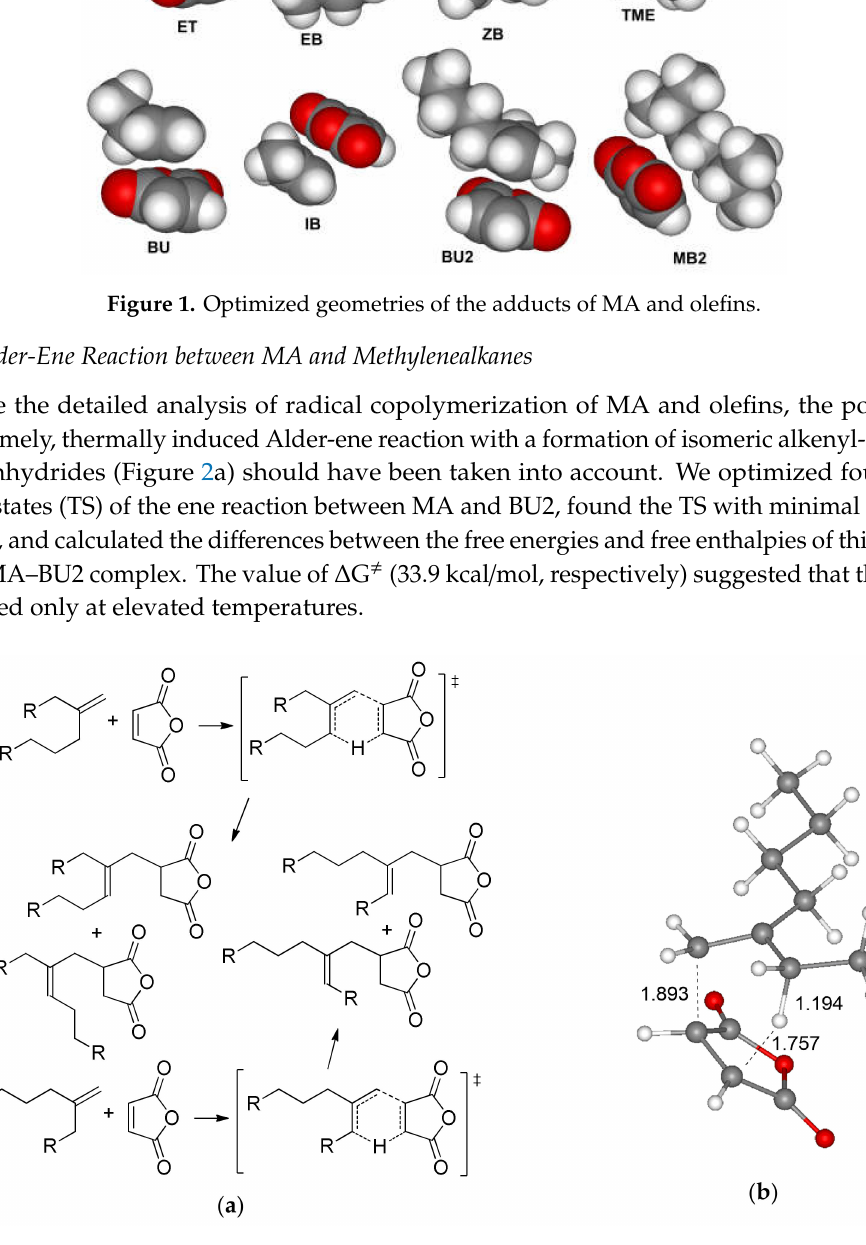
Figure 2. ( a ) The Alder-ene reaction between MA and methylenealkanes; ( b ) Optimized geometry